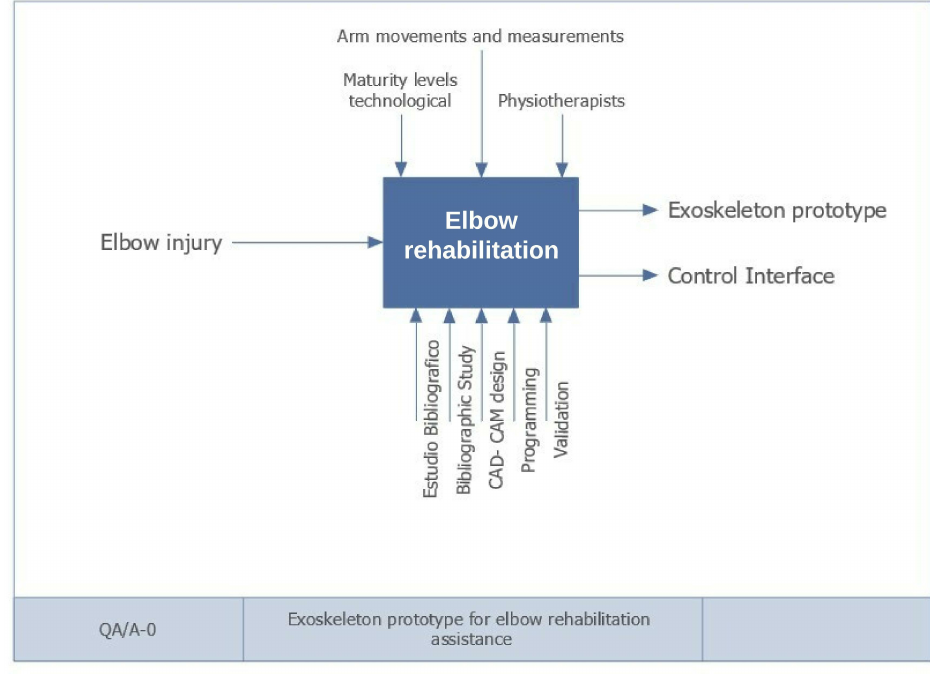
Figure 3. General system diagram IDEF A-0.